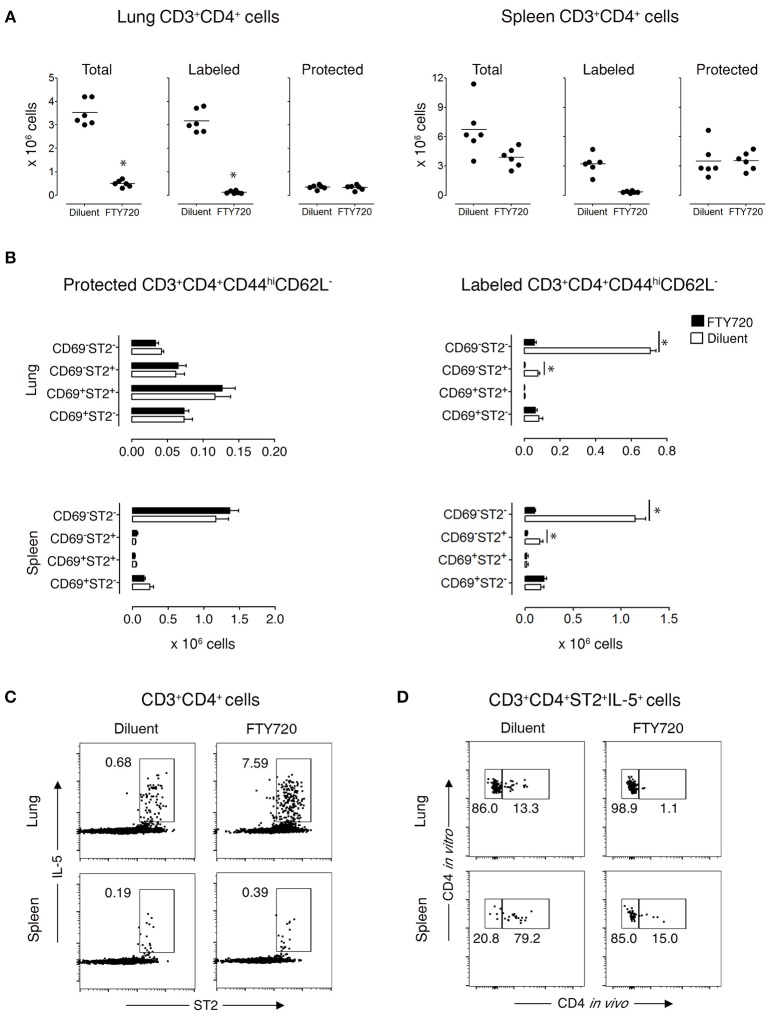
Protected allergen-specific CD3+CD4+ T cells remain in the lung and spleen after FTY720 treatment. Mice at D172 and D174 of recovery from disease initiation were treated with FTY720 (0.5 mg/kg) or diluent i.p. daily for three consecutive days. One day later, mice were assessed 10-15 min after i.v. injection of anti-CD4 mAb to determine the effect of treatment on labeled and protected CD3+CD4+ T cell populations in lung and spleen. (A) Number of total, labeled, and protected CD3+CD4+ T cells in lungs and spleens of control- and FTY720-treated groups. Data are presented as individual values (dots) and group means (lines) compiled from 2 independent experiments (n = 6). *p < 0.05 using Student's t-test. (B) Number of protected and labeled CD3+CD4+CD44hiCD62L− expressing surface markers CD69 and ST2 in spleens and lungs of diluent- and FTY720-treated mice. Data are presented as mean ± SEM compiled from two independent experiments (n = 6). *p < 0.05 using two-way ANOVA. (C) Representative dot-plots indicating that allergen-specific Th2 cells remain in the lungs and spleens of recovered mice after FTY720 treatment. Lung and spleen cells from three mice/group were isolated, pooled, and stimulated for 9 h with OVA-loaded peritoneal macrophages. Dot-plots show ST2 vs. intracellular IL-5 on gated CD3+CD4+ cells. Numbers indicate the percentage of cells in the respective cytokine-producing gate. Data are representative of two independent experiments. (D) Dot-plots show frequency of labeled and protected IL-5-producing CD3+CD4+ST2+ T cells upon stimulation with OVA-loaded peritoneal macrophages. Data are representative of two independent experiments.